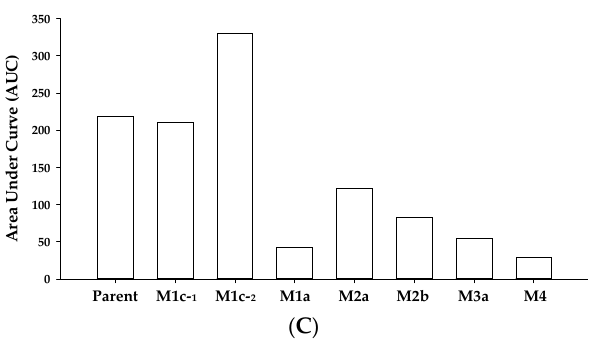
Figure 8. Metabolic profiles of HSG4112 in rat plasma after oral administration (100 mg/kg/day, 28th day, n = 3). ( A ) Plot for time-peak area of HSG4112 and its metabolites. ( B ) Plot for time-plasma concentration of HSG4112, M1c-1 and M1c-2. ( C ) Area under curve values of HSG4112 and its metabolites calculated from ( A ).